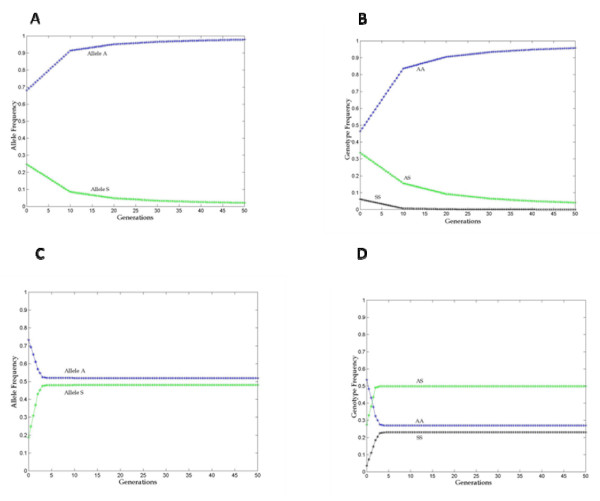
Simulation of allele and genotype frequencies of the βS polymorphism for 50 generations in Hausa and Massalit villages. Simulation is based on actual genotype data and with projections based on fitness equation as described in the materials and methods section. Figure 2(A): Simulation for HbA and Hb S allele frequencies over 50 generations in Hausa. Figure 2(c): Simulation for HbA and Hb S alleles frequencies over 50 generations in Massalit. Figure 2(B): Simulation for HbA and Hb S genotypes frequencies over 50 generations in Hausa. Figure 2(D): Simulation for HbA and Hb S genotypes frequencies over 50 generations in Massalit. All simulations are based on fitness measures as calculated from genotypes of two generations.